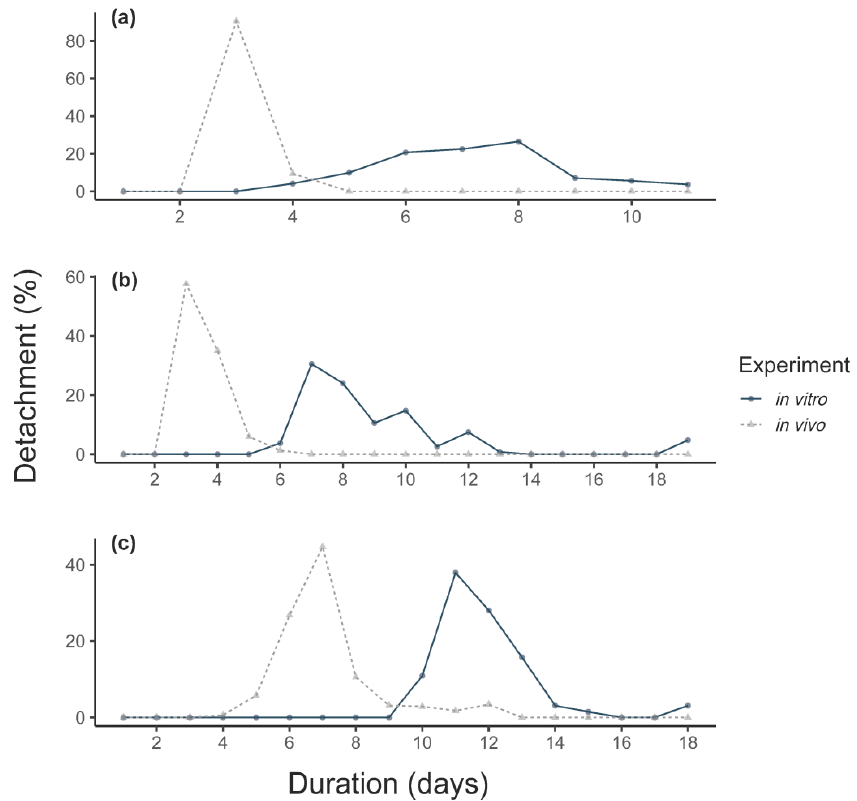
Figure 1. Mean feeding duration of ( a ) larvae, ( b ) nymphs and ( c ) adults (F 0 + F 1 ) in vitro compared to in vivo fed ticks fed on calves (means). Detachment is presented as a % of all detached